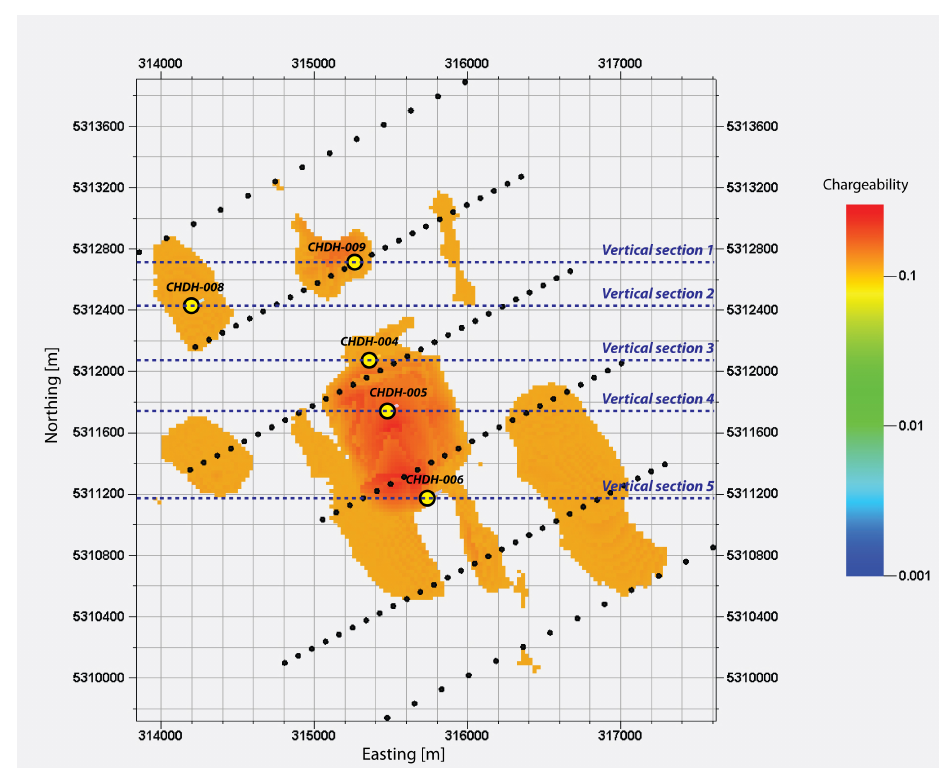
Figure 18. A top view of the interpreted target mineralized